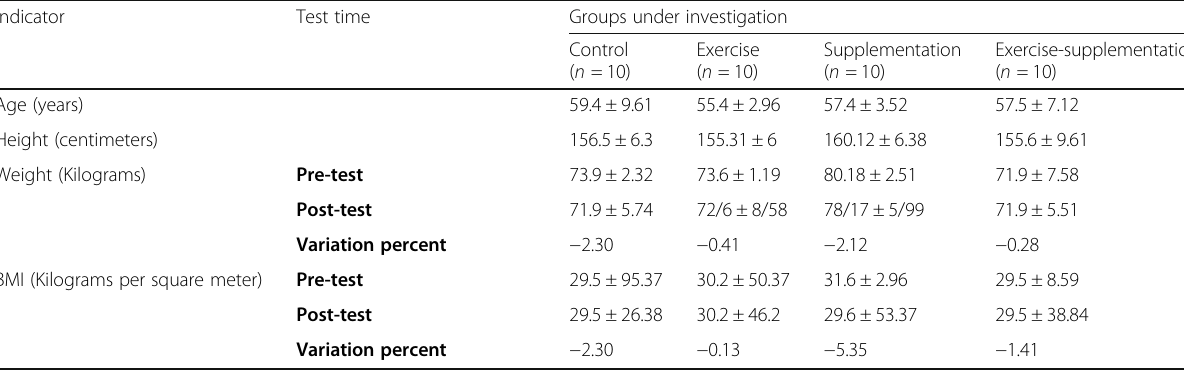
Table 1 Mean ± standard deviation of the anthropometric characteristics of subjects in the pre-test and post-test groups Indicator Test